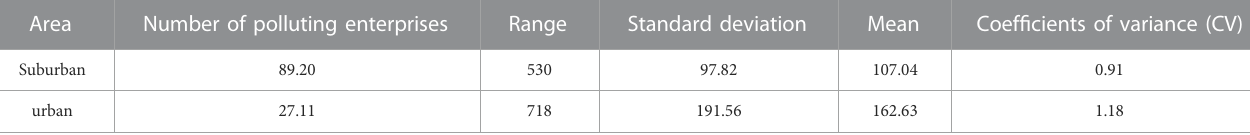
TABLE 2 Descriptive statistics of the number of water-polluting enterprises in urban and suburban areas.